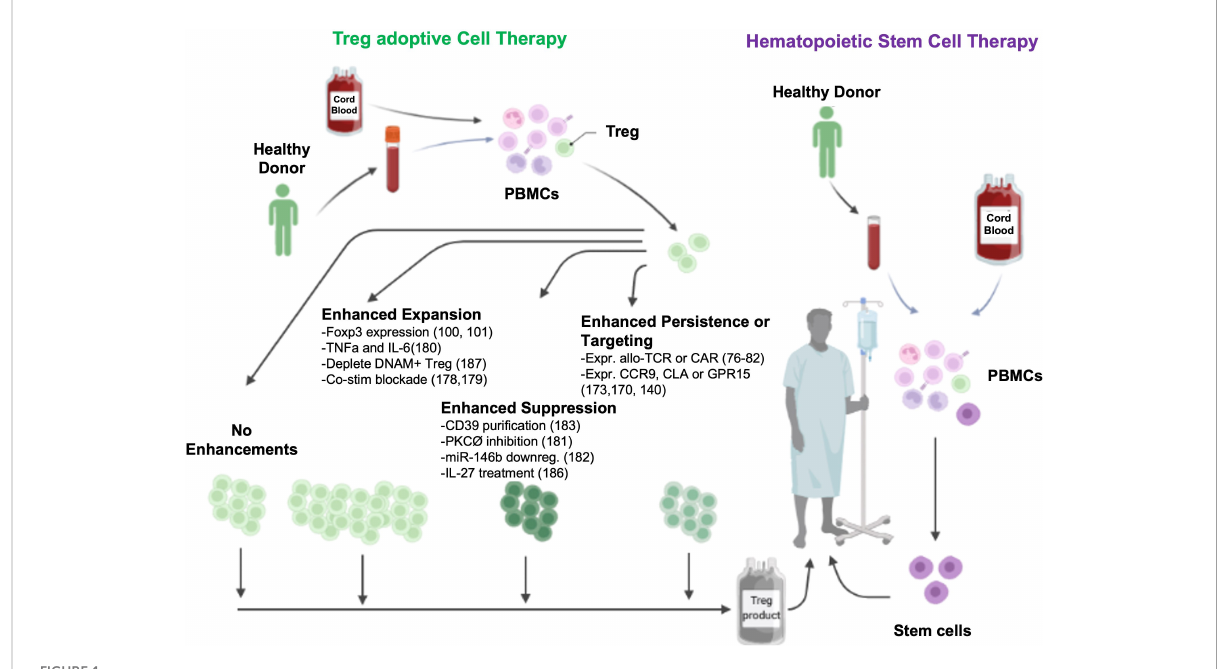
FIGURE 1 Potential ex vivo mechanisms to enhance Treg